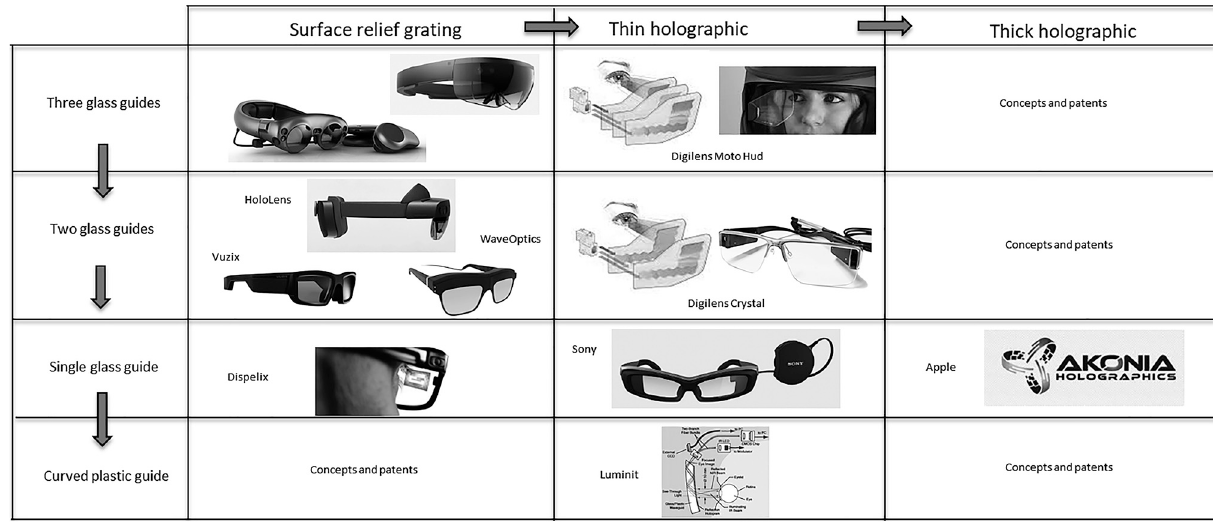
Figure 16: Summary of waveguide combiner architectures with 1D or 2D EPE